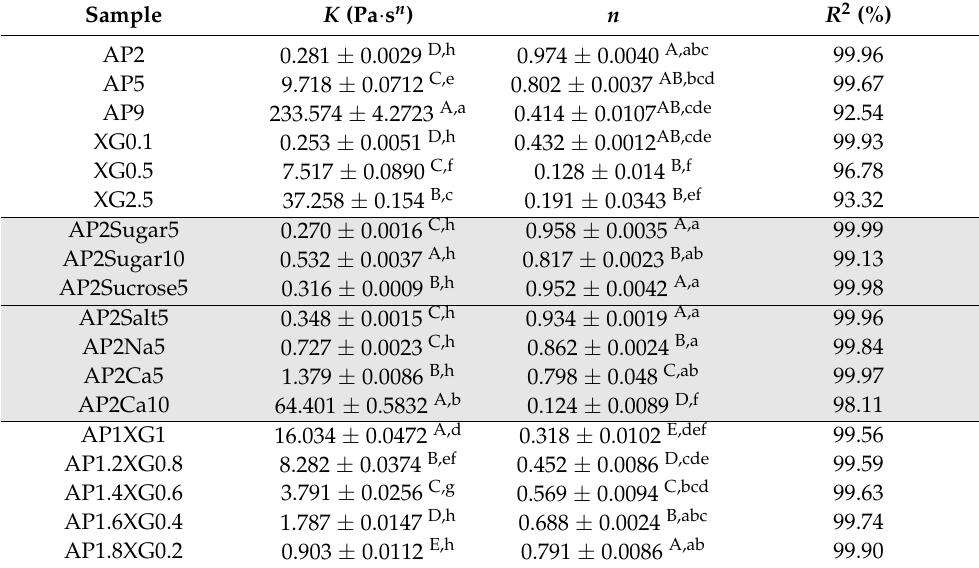
Table 2. Regression models of power law for thickened fluid matrices formulated with the sole thickener of AP or XG, AP incorporating sugar or cations, and a AP-XG composite *.